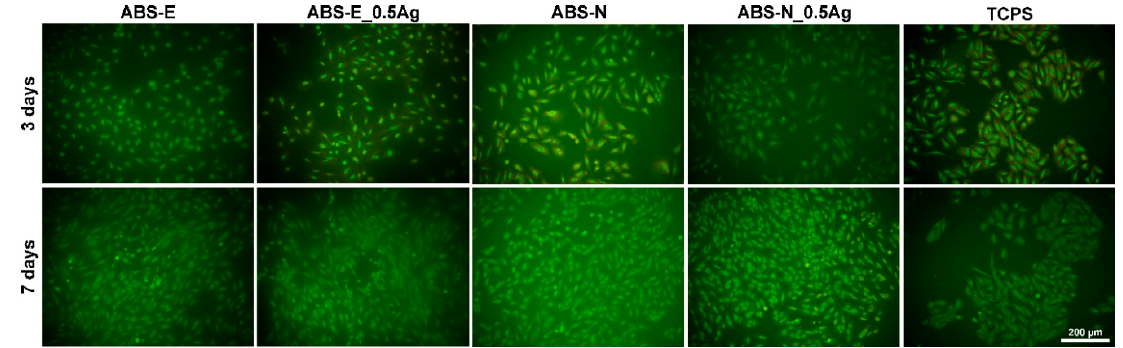
Figure 7. Cytotoxicity of materials evaluated in contact with Saos-2 ( A ) and Hs680.Tr ( B ) cells. The results are presented as mean values ± standard deviation. Statistically significant differences ( p < 0.05) between the tested materials are marked a-d for 3-day culture and A-C for 7-day culture.